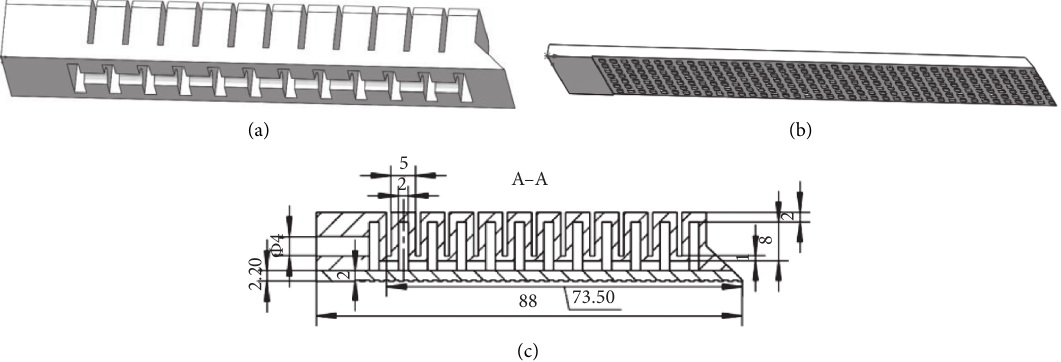
Figure 4: The design process of one finger. (a) The air chamber part of the finger. (b) The cover part of the finger. (c) The section view of the finger.